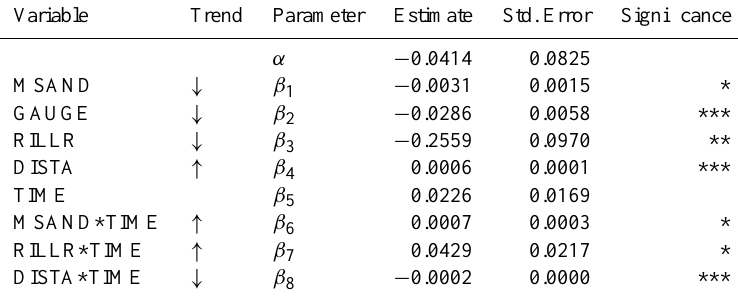
Table 6. Parameter estimates and significances for the model estimating surface height change (DHEIGHT) as shown in Eq. (10). Significance of linear predictor variables’ significant influences. ↑ , ↓ : DHEIGHT increases (decreases) with increasing values of the respective predictor variable. Thus, ↓ indicates a tendency towards erosion while ↑ indicates trends that counteract